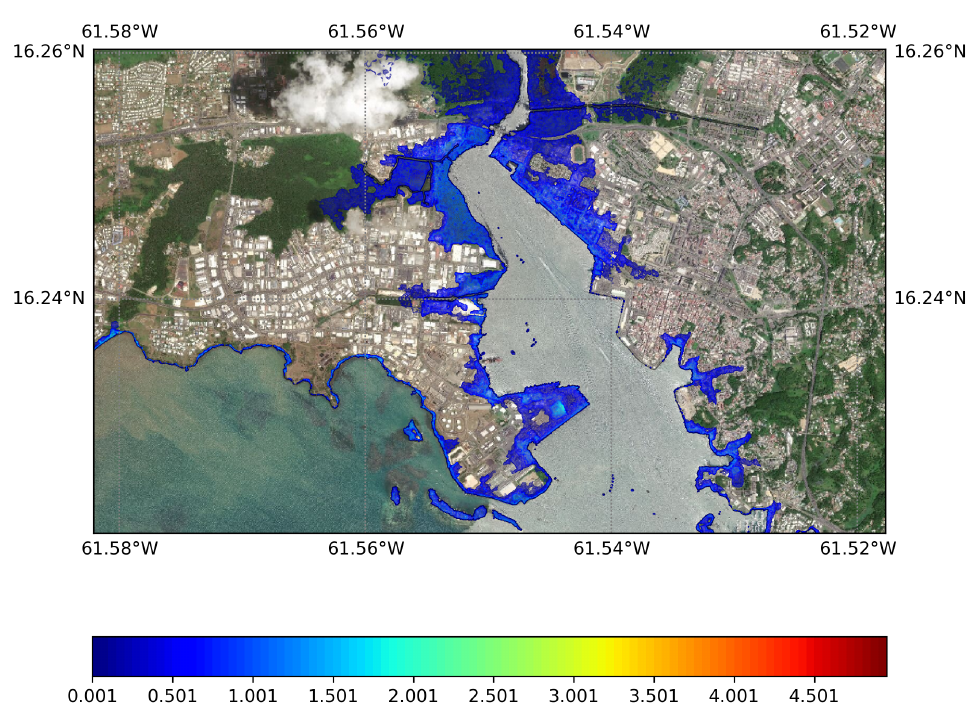
Figure 11. Maximum water depth for the Pointe-à-Pitre and Baie-Mahault region, Grande-Terre for the 80 km 3 scenario with Sea Level